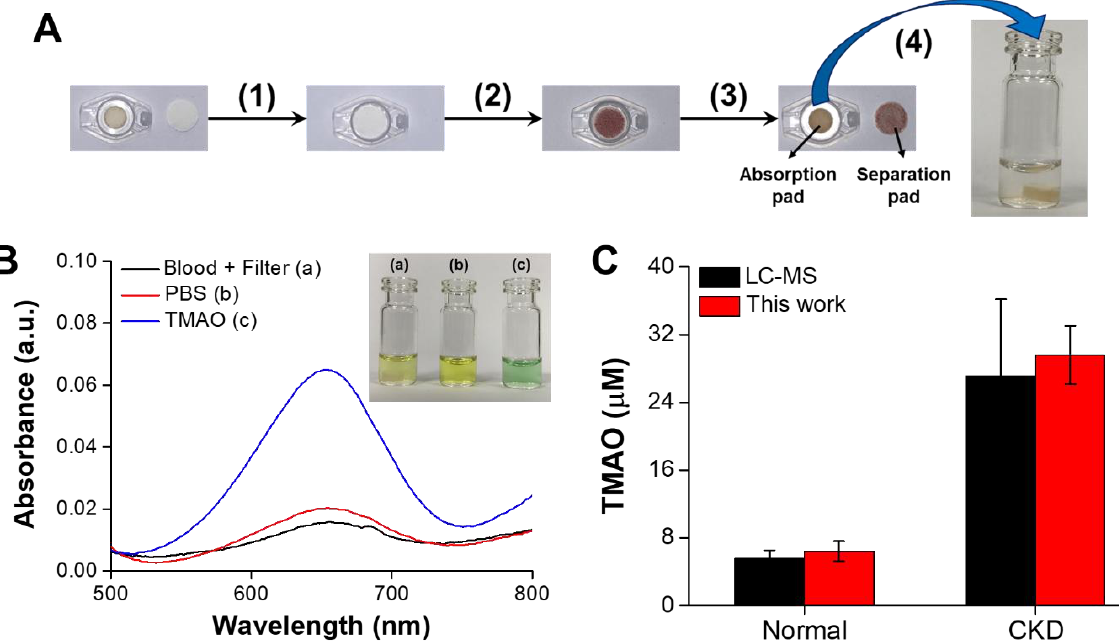
Figure 5. ( A ) The design and principle of colourimetric TMAO detection using whole blood based on the combination of a plasma separation pad as a erythrocyte trap and an absorption pad as serum/plasma trap to filter erythrocytes and haemachrome as follows: (1) the absorption pad is covered with the separation pad; (2) 50 μ L of whole blood is dropped on the separation pad; (3) the serum/plasma is collected in the absorption pad and (4) the absorption pad with serum/plasma is placed into a glass vial for TMAO detection; ( B ) UV-vis absorption spectra and visual colour changes of the catalysed oxidation of TMB in two groups to confirm that the erythrocytes and haemachrome of whole blood could be filtered and that normal serum/plasma would not cause proton depletion, similar to PBS; the inset is a corresponding digital photo; ( C ) TMAO concentrations in 8 whole blood samples from normal rats and 8 whole blood samples from CKD that were measured using LC – MS and the proposed colourimetric assay for CKD monitoring. The values are means ± SD ( n = 8).